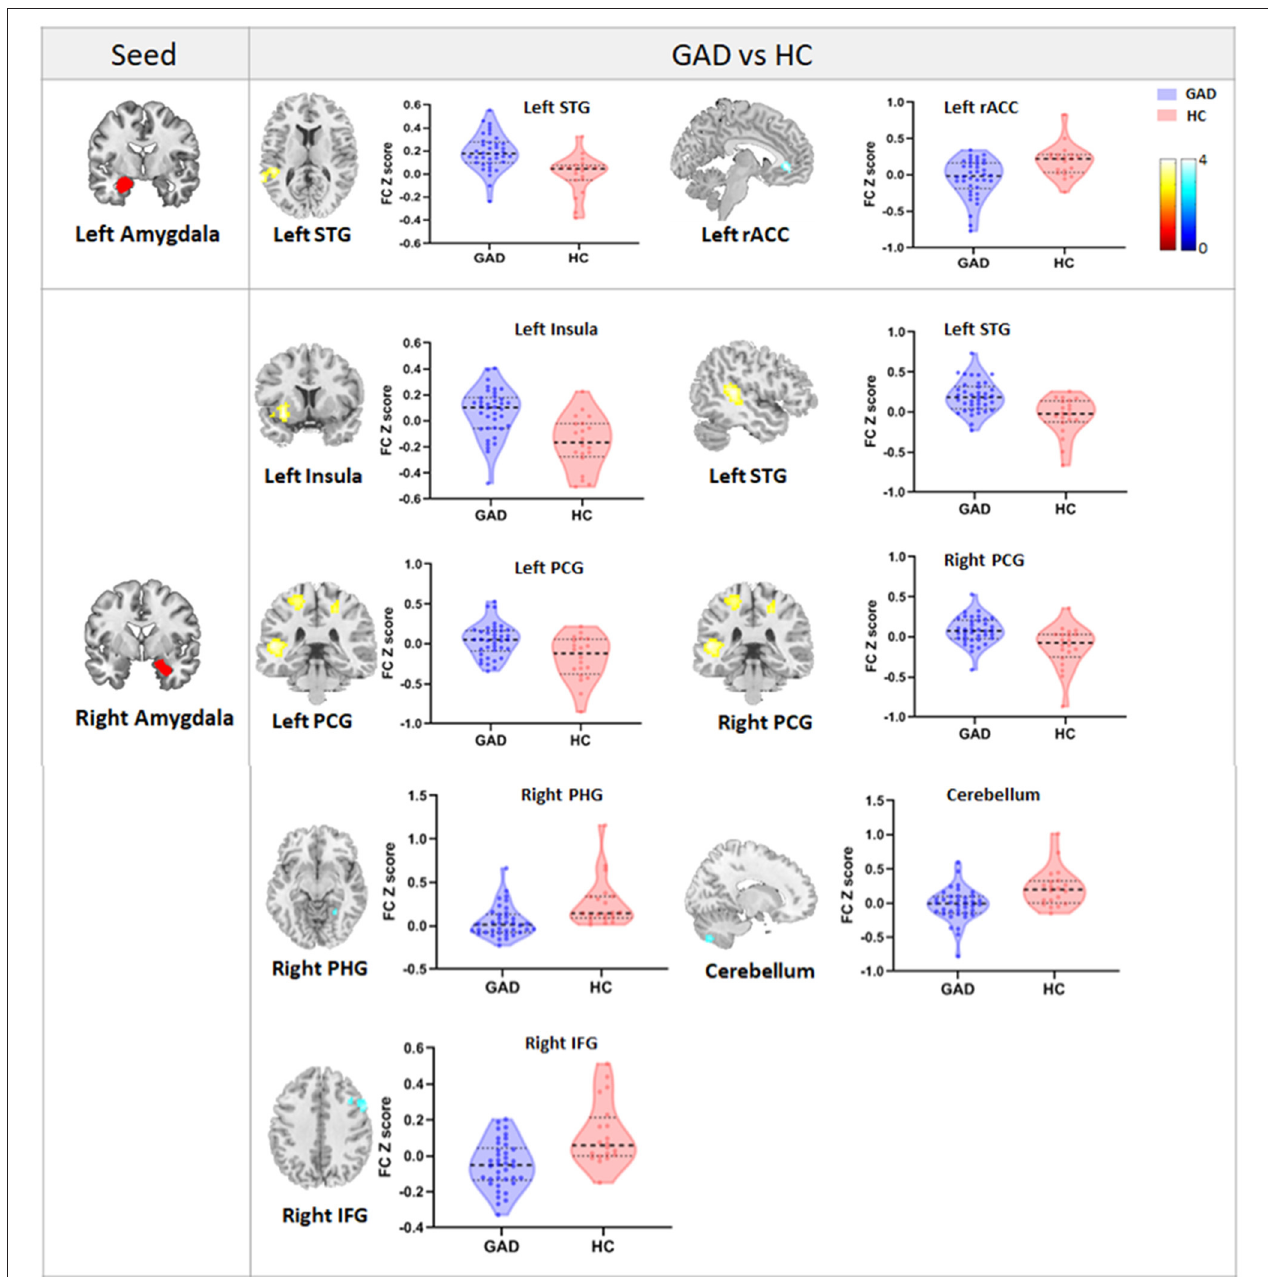
FIGURE 1 | The figure shows the group differences in FC between the bilateral amygdala and the whole brain. Violin plots reflect the mean FC Z -scores in each group, and error bars represent standard errors of the means. Warm/cold color indicates increased/decreased FC in GAD patients compared with HCs. STG, superior temporal gyrus; rACC, rostral anterior cingulate cortex; PCG, postcentral gyrus; PHG, parahippocampal gyrus; IFG, inferior frontal